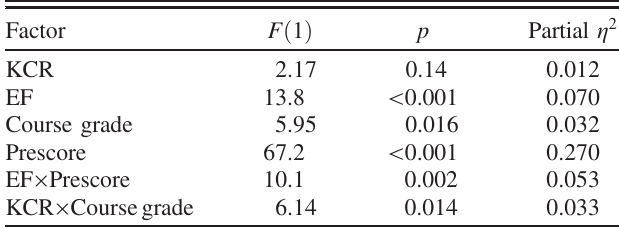
TABLE III. Experiment 2 univariate ANOVA results, excluding control. Note that R 2 ¼ 0 . 39